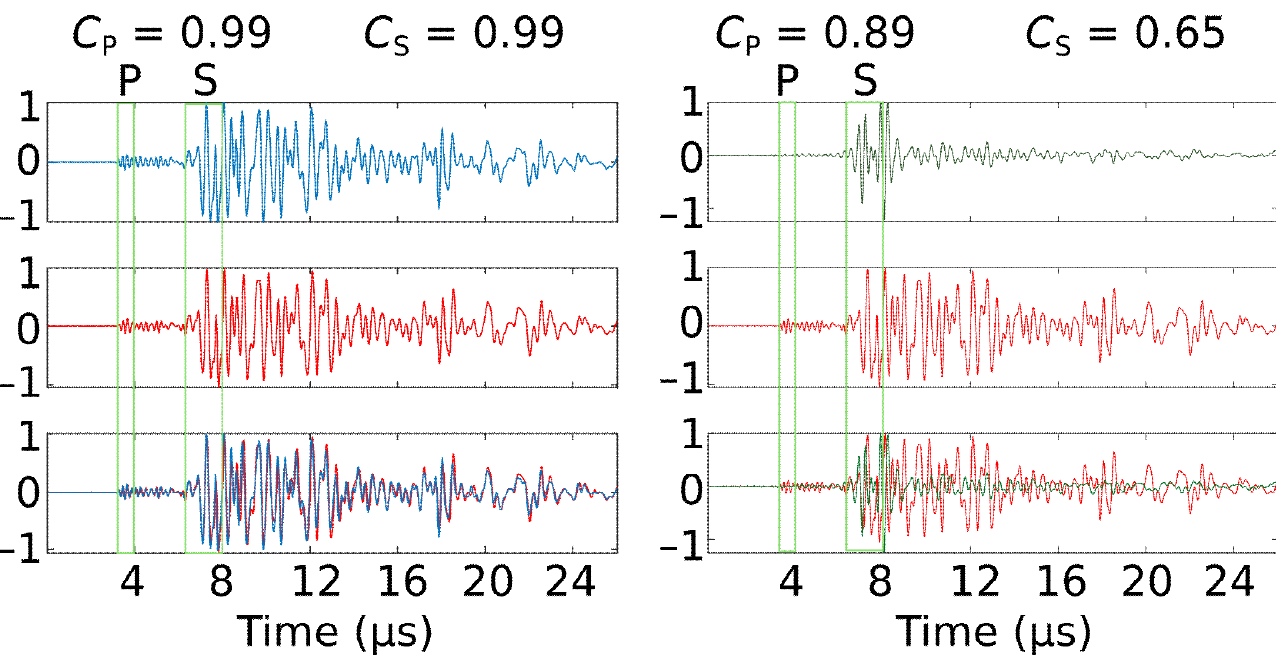
Figure 2. Example of coherency computation for two pairs of AEs (red-blue on the left; red-green on the right). Green boxes represent the time interval used to calculate coherency. The pair on the left shows highly similar waveforms while the pair on the right shows dissimilar AEs. The coherency value is given both for P and S waves on the top.